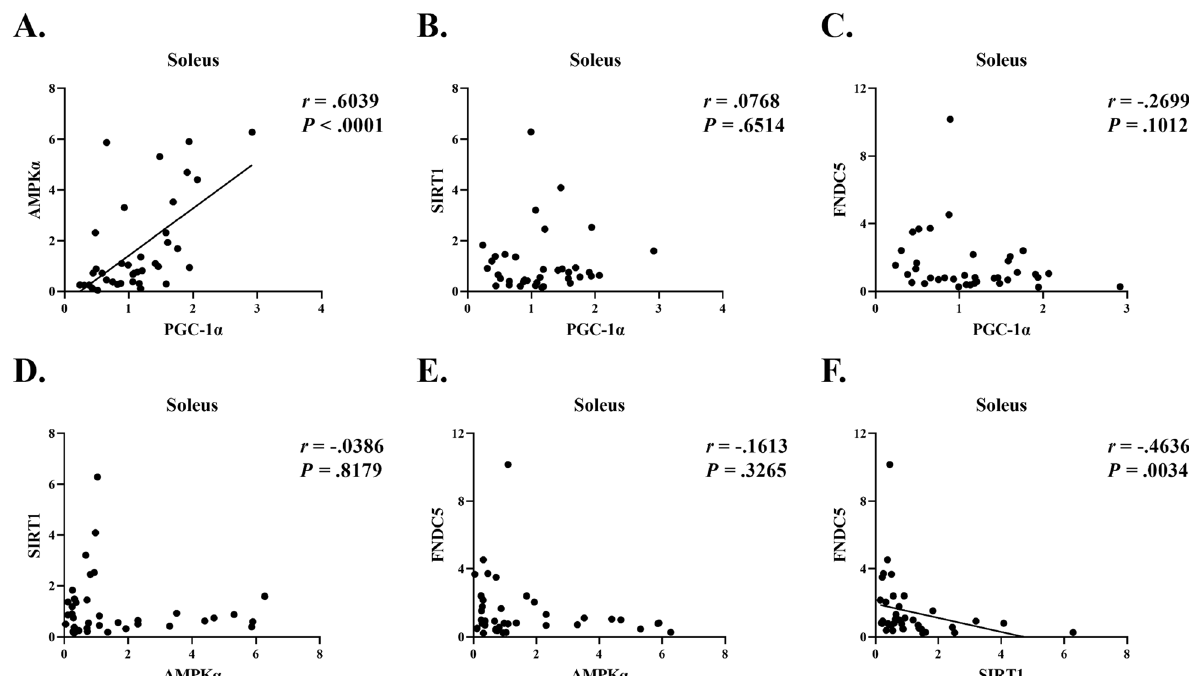
Fig. 7 Correlation analysis between expressed proteins in the soleus muscles